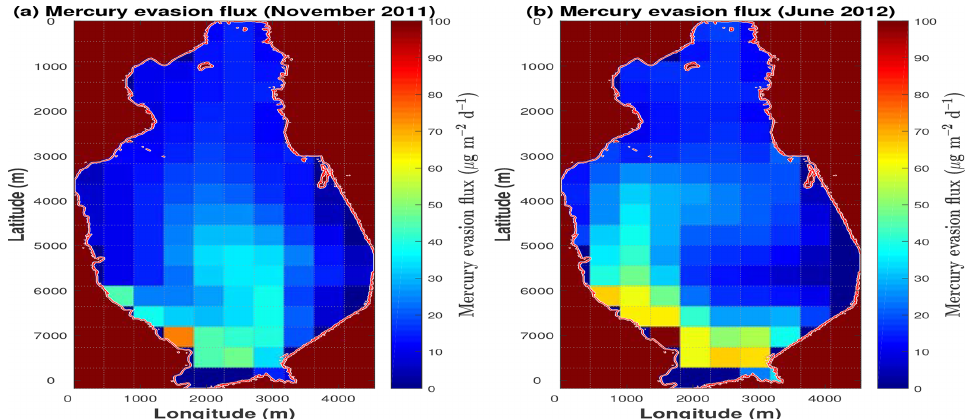
Figure 6. Distribution of the Hg 0 flux calculated at the seawater–atmosphere interface. The maps reproduce the spatial distribution of the evasion flux in the Augusta Bay during the two sampling periods, i.e., 29–30 November 2011 (a) and 23–25 June 2012 (b) .